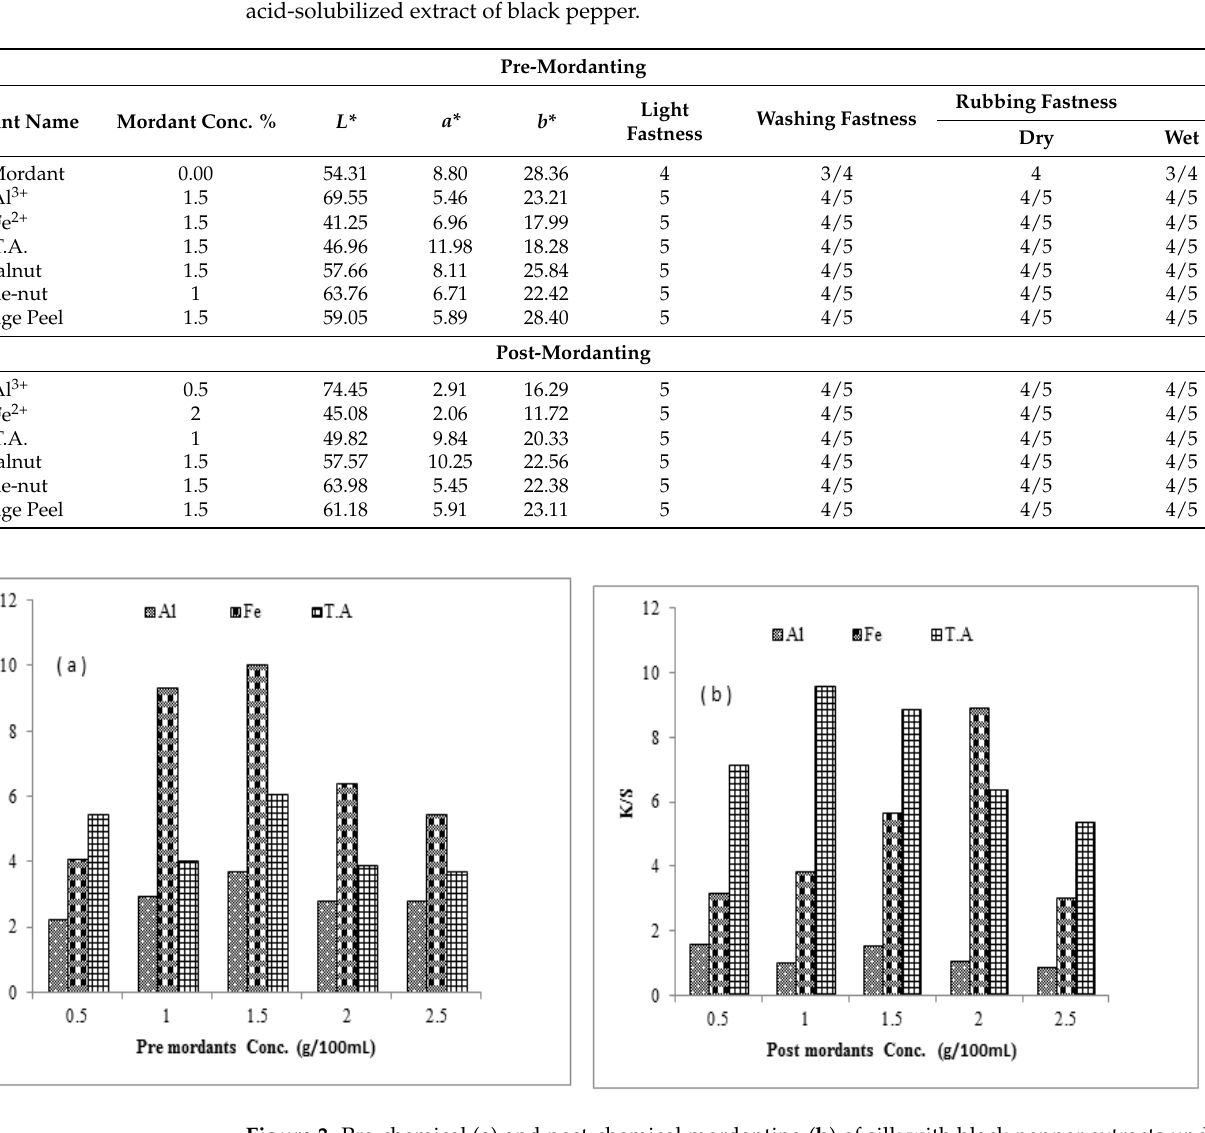
Figure 3. Pre-chemical ( a ) and post-chemical mordanting ( b ) of silk with black pepper extracts under selected conditions. Table 2. Colorfastness ratings of chemical mordant and bio-mordanted silk fabric dyed using an acid-solubilized extract of black pepper.